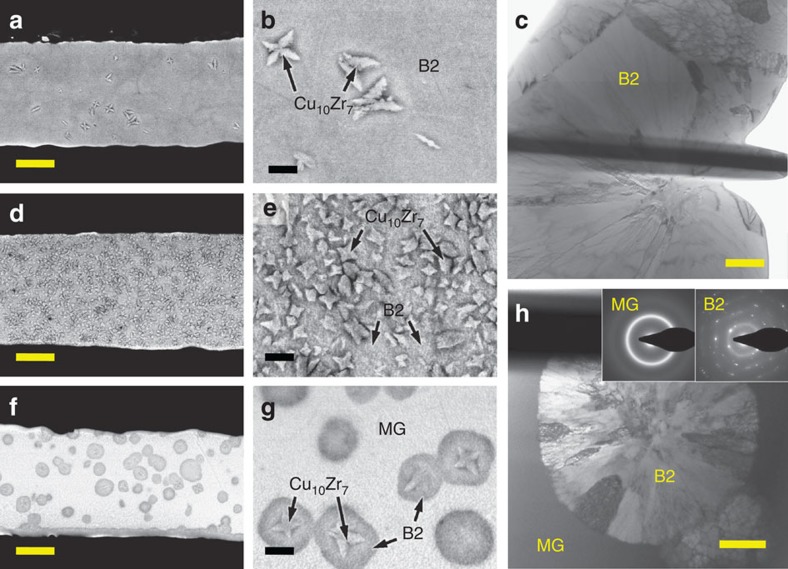
Microstructure of Cu47.5Zr47.5Al5 ribbons after rapid Joule heating.(a) SEM image of fully crystalline sample (FC-B2). Scale bar, 10 μm. (b) SEM image of fully crystalline sample (FC-B2). Scale bar, 2 μm. (c) TEM image of fully crystalline sample (FC-B2). Scale bar, 1 μm. (d) SEM image of ultrafine-structured composite (UFSC-B2). Scale bar, 10 μm. (e) SEM image of ultrafine-structured composite (UFSC-B2). Scale bar, 2 μm. (f) SEM image of metallic glass-matrix composite (MG-B2). Scale bar, 10 μm. (g) SEM image of metallic glass-matrix composite (MG-B2). Scale bar, 2 μm. (h) TEM image of metallic glass-matrix composite (MG-B2). Scale bar, 1 μm. Note B2, B2 CuZr phase; MG, metallic glass.